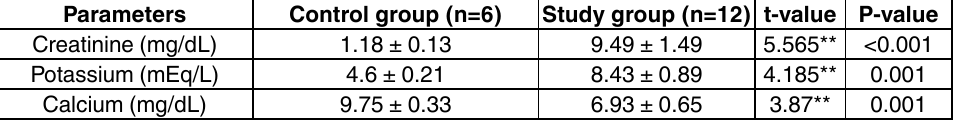
table 2. Comparison of serum biochemical parameters between control group and study group